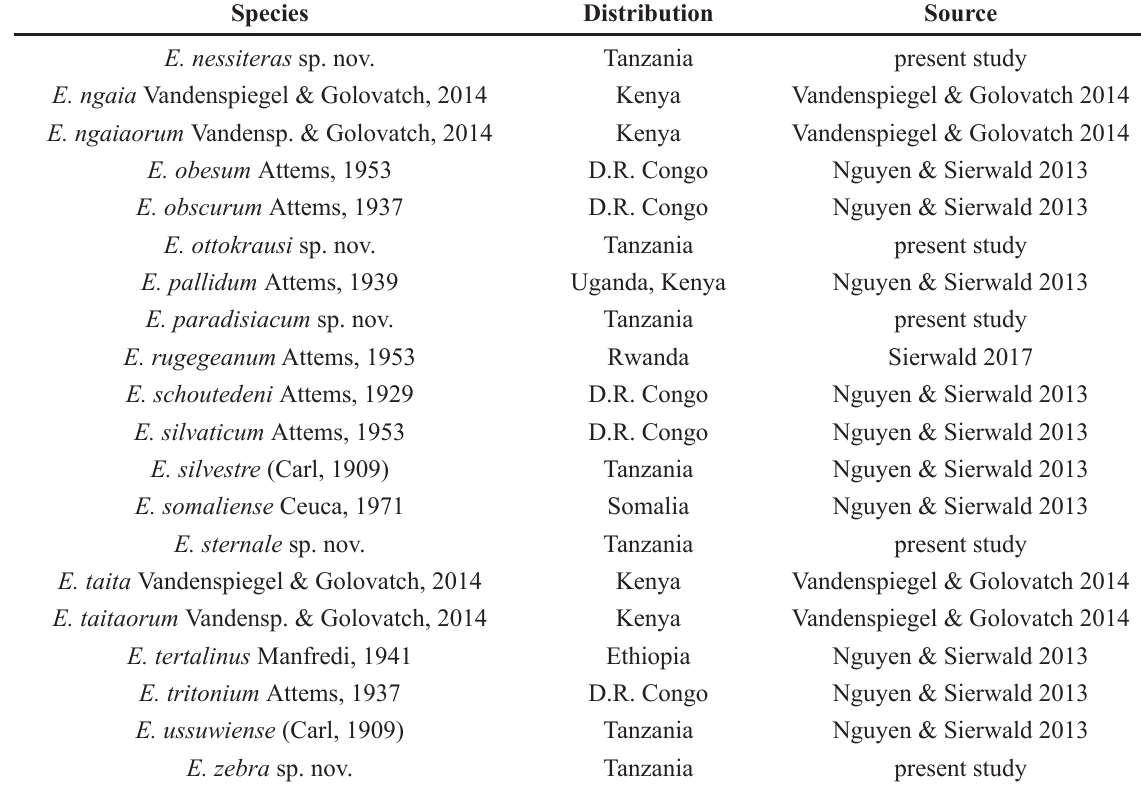
Table 2. Species of Eviulisoma Silvestri, 1910.